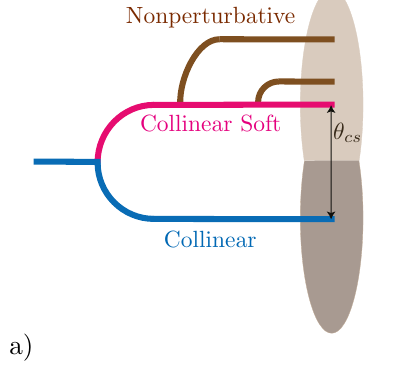
Figure 9 . Two example scenarios where (a) the NP subjets get clustered at di(cid:11)erent stages and (b) where the NP subjets are clustered together (cid:12)rst before they get paired with another perturbative branch. In (b) although one the NP particles lies outside the cone of radius (cid:18) cs centered at the CS subjet, the combined NP branch gets eventually clustered. This requires (cid:2) (cid:14)(cid:14) rather than individual